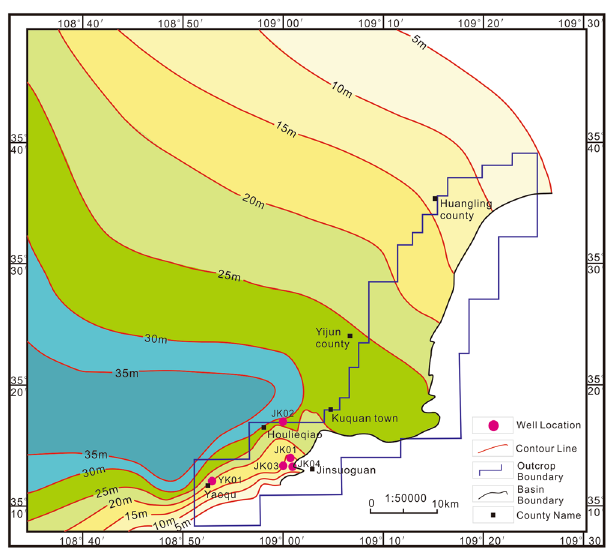
Figure 3. Oil shale thickness distribution of the Yanchang Formation in southeast Ordos Basin, The figure was created using the Chinese version of CorelDraw Graphic Suite X8.